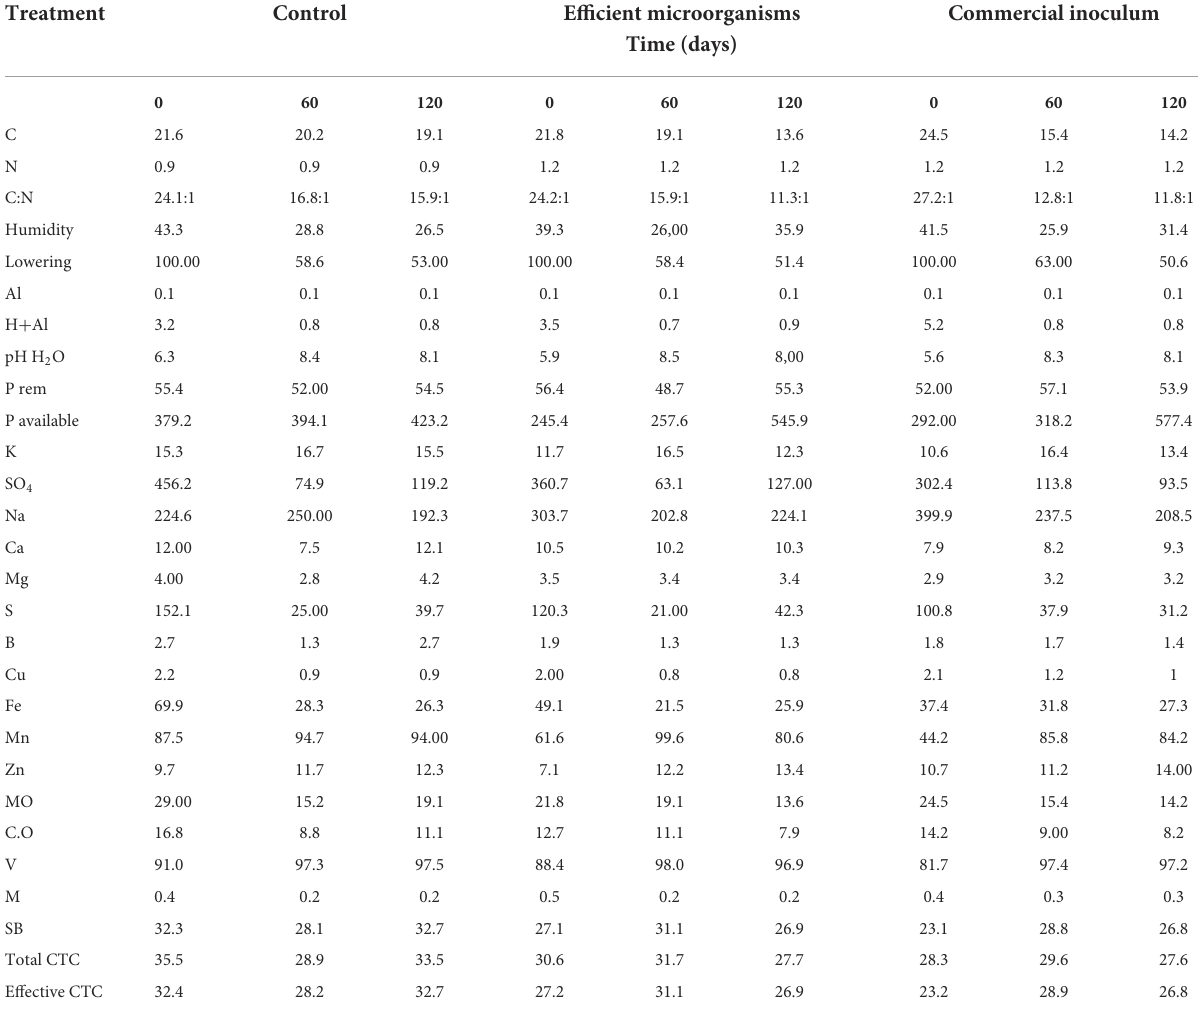
TABLE 2 Physical and chemical parameters during composting for control, efficient microorganisms, and commercial inoculum treatments. Treatment Control Efficient microorganisms Commercial inoculum Time